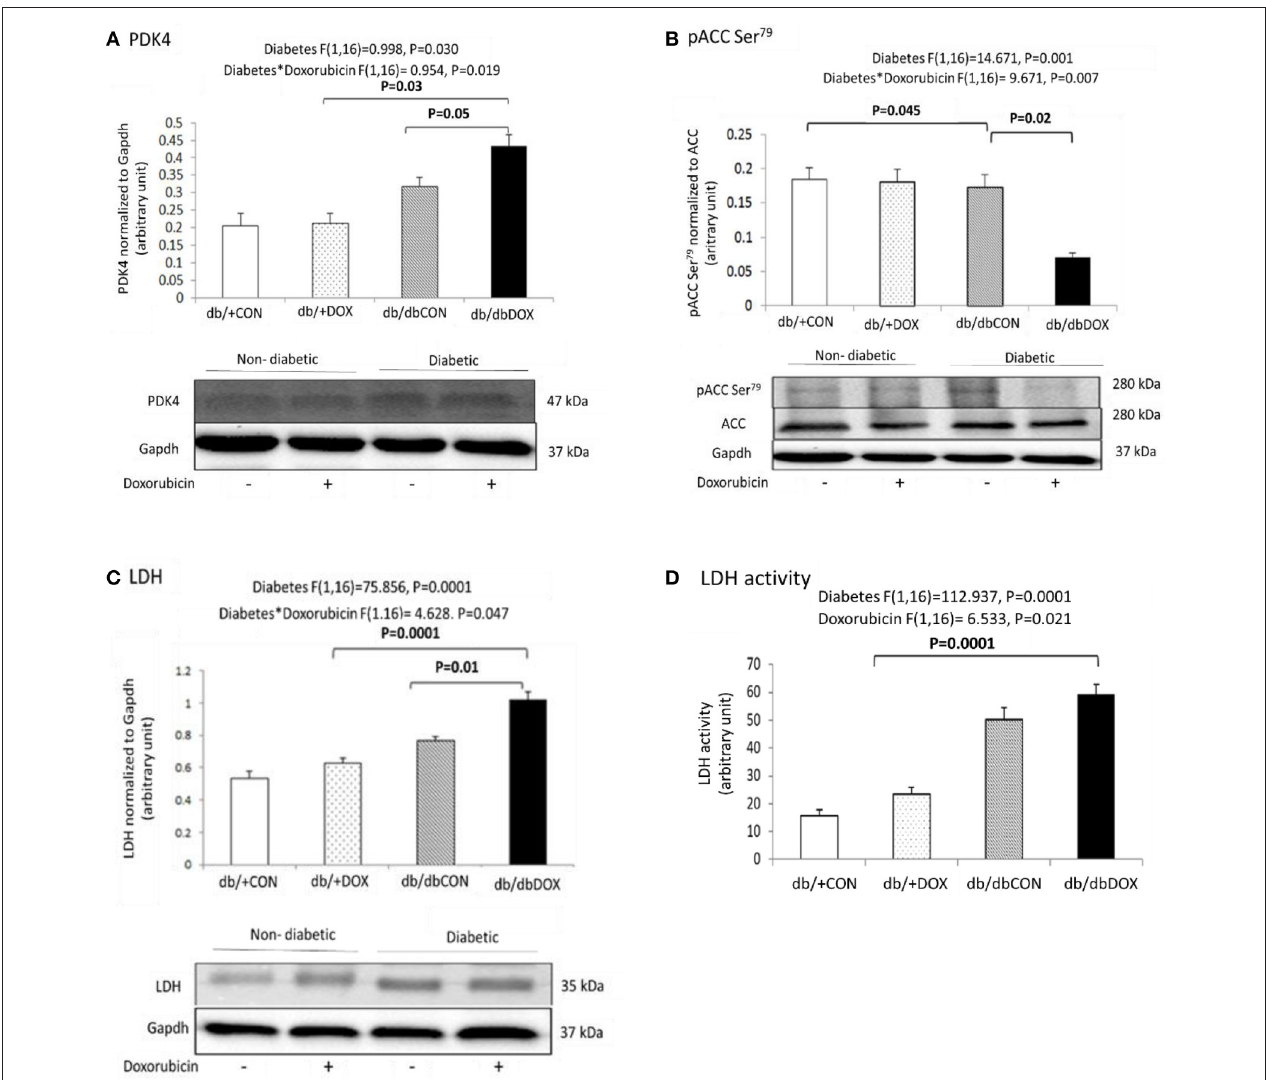
FIGURE 5 | Non-diabetic and diabetic skeletal muscle glycolytic mechanism after DOX exposure examined by phosphorylation statuses of PDK4 (A) and ACC (Ser79) (B) LDH protein (C) LDH activity (D) are shown. Data are expressed as mean ±